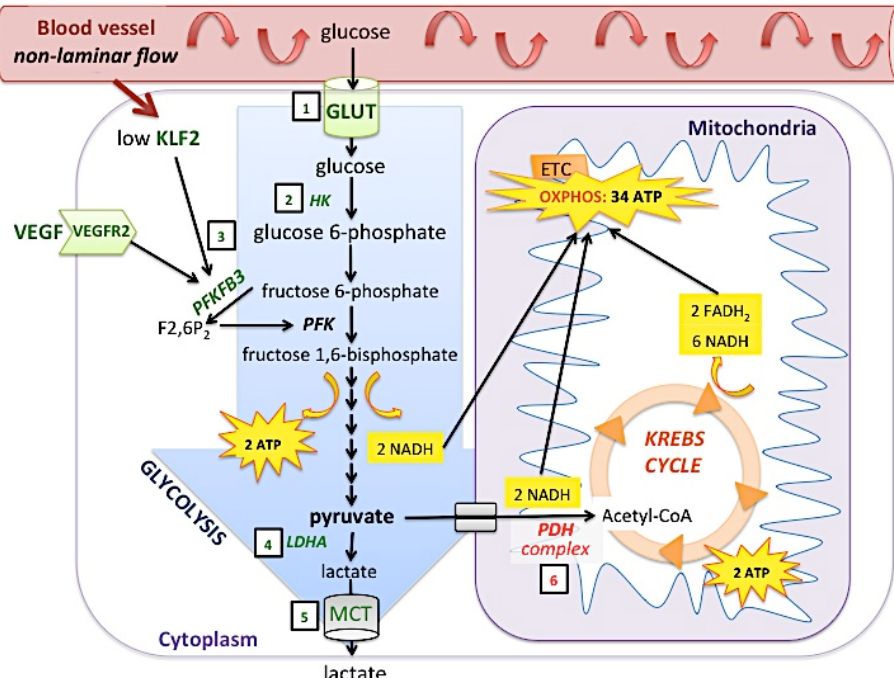
Figure 5. Glucose metabolism is regulated by hypoxia-inducible factors (HIFs). During glycolysis, glucose enters the cytoplasm through the glucose transporter (GLUT) and is transformed into glucose 6-phosphate by hexokinase (HK). Eight successive enzymatic reactions then occur to produce 2 molecules of pyruvate, 2 ATP and 2 NADH. At the end, cytosolic pyruvate has two possibilities: transformation into lactate by the enzyme lactate dehydrogenase A (LDHA)—lactate being then exported through the monocarboxylate transporter (MCT), or transferred into the mitochondria and transformed into Acetyl-CoA via the pyruvate dehydrogenase complex (PDH complex). In the second option, Acetyl-coA goes into the Krebs cycle to produce 2 ATP, 6 NADH, and 2 FADH 2 . NADH and FADH 2 will further be used in redox reactions in the electron transport chain (ETC) to produce more ATP via oxidative phosphorylation (OXPHOS). HIF intervenes in several steps during glucose metabolism: by inducing GLUT it allows more entry of glucose (1) and by inducing hexokinase (2) and PFKFB3 (3), it enhances glycolysis. Note that non-laminar blood flow decreases the expression of Kruppel-like factor 2 (KLF2), which has otherwise an inhibitory action on HIF-1 and PFKFB3 expression. VEGF and its receptor VEGFR2 are also induced by HIF-1 and enhance PFKFB3 expression. Further, pyruvate is pushed towards lactate transformation by up-regulation of LDHA (4) and some isoforms of MCT (5). At the same time, HIF prevents the PDH complex from transforming pyruvate into Acetyl-coA (6). Green: activation by HIF, Red: inhibition by